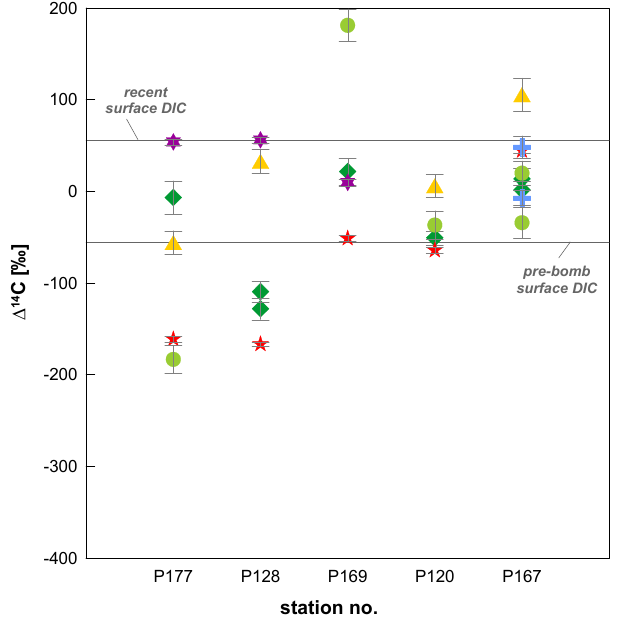
Fig. 3. Radiocarbon concentrations ( 1 14 C) of purified chloro- and pheopigments. Error bars denote 1 σ analytical uncertainties.